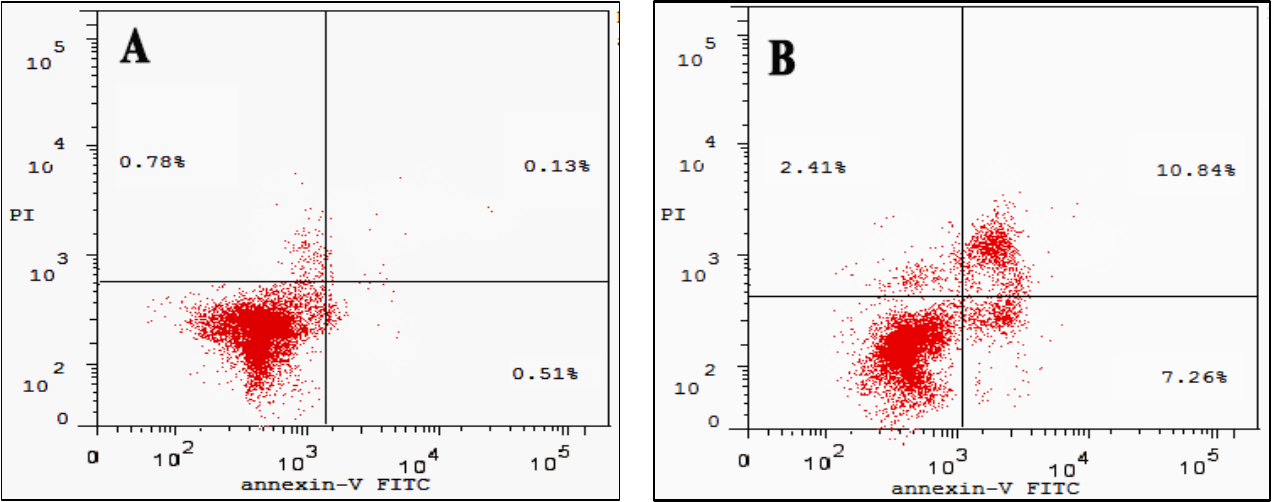
Figure 9. ( A ) Apoptosis analysis for Caco-2 (control); ( B ) Apoptosis analysis for Caco-2 cancer cell line was treated with CA-BSA-NPs.